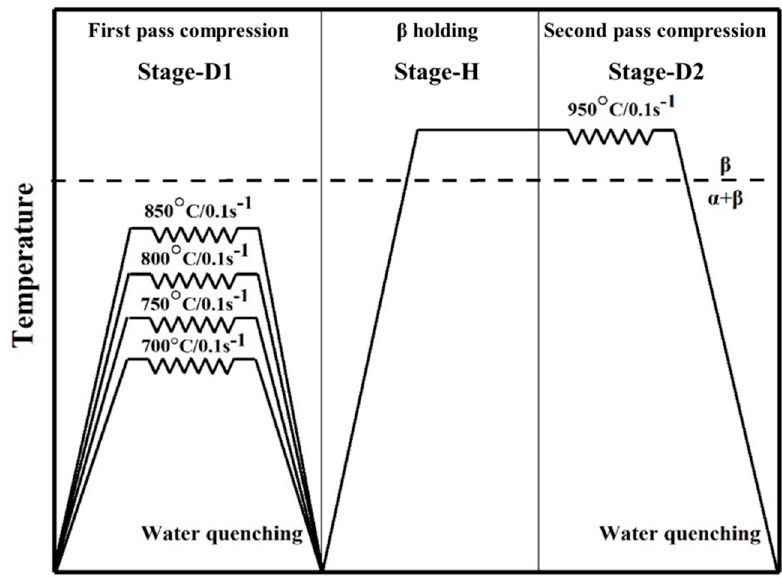
Figure 2. Schematic diagram of the thermal compression process. The hot-compressed samples were cut along the compression direction using electro- discharge machining. Then, they were mechanically ground by SiC paper and finally polished by a twin-jet electropolisher at a − 30 ◦ C surrounding temperature and 30 V operating voltage. Specimens were jet-thinned by Kroll’s reagent, which was composed of 300 mL methanol, 175 mL N-butyl alcohol, and 25 mL perchlorate acid. The microstructure of the compressed samples was characterized by scanning electron microscope (SEM) (FEI Czech Republic s.r.o., Brno, Czech Republic) and electron backscat- tered diffraction (EBSD) (FEI Czech Republic s.r.o., Brno, Czech Republic) using 0.2 µ m and 0.6 µ m step sizes and a 20 kV operating voltage. Information about the